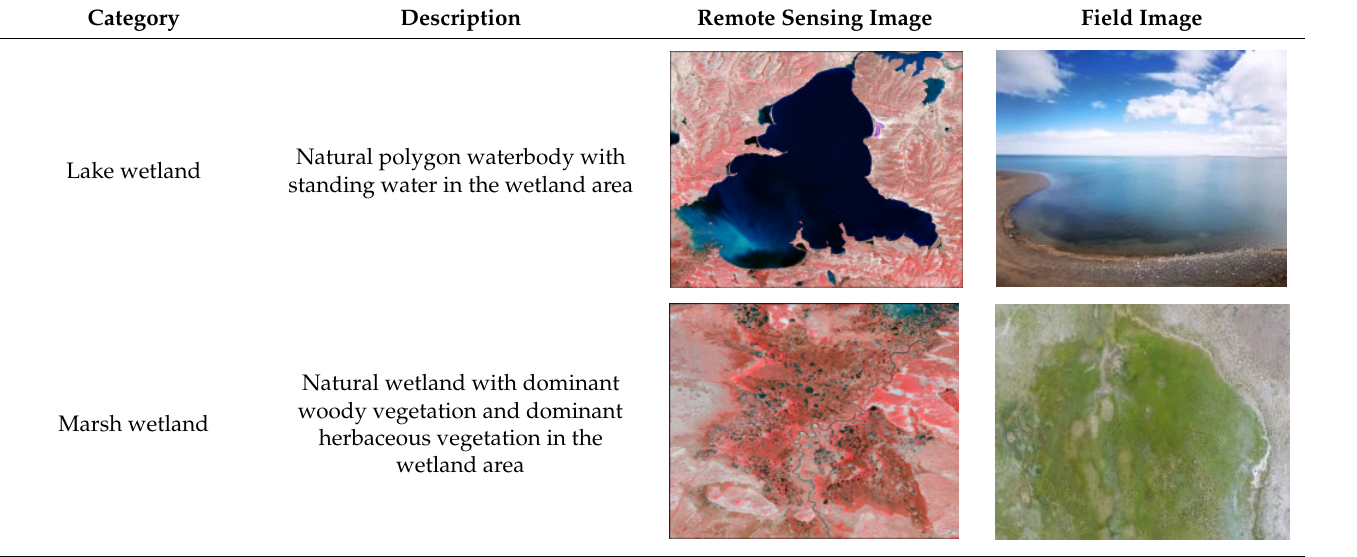
Table 1. Wetland classification system for remote sensing in the YRSNP.